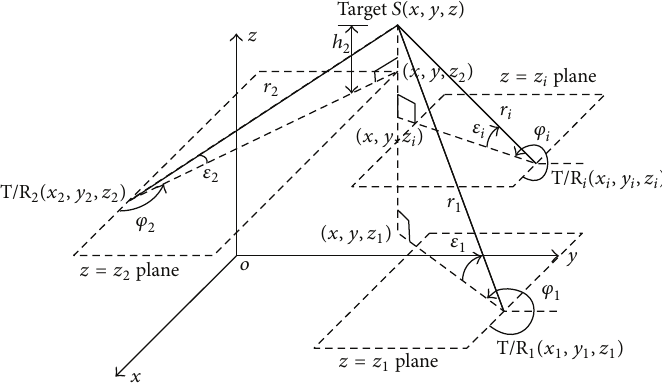
Figure 1: Multistation Array